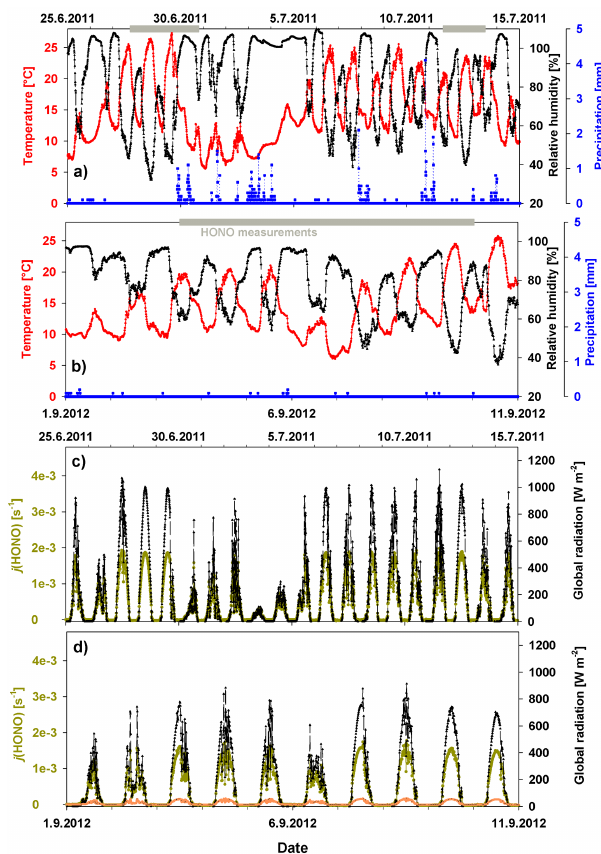
Figure 1. Temperature (red), relative humidity (RH, black) and pre- cipitation (blue) averaged for a 10min interval are shown in pan- els (a) for 25 June to 15 July 2011 (IOP-3), and (b) for 1 Septem- ber 2012 to 11 September 2012 (IOP-4). Periods when HONO vertical profiles were measured are indicated by grey bars at the top of the graphs. Panels (c) and (d) show solar global irradiance (black) and j (HONO) in dark yellow, calculated according to Trebs et al. (2009), for the respective campaigns. Additionally, j (HONO) at the forest floor (orange) was calculated by applying a factor of 10 taking into account attenuation by the canopy (Sörgel et al., 2011b). All data were taken from the Pflanzgarten